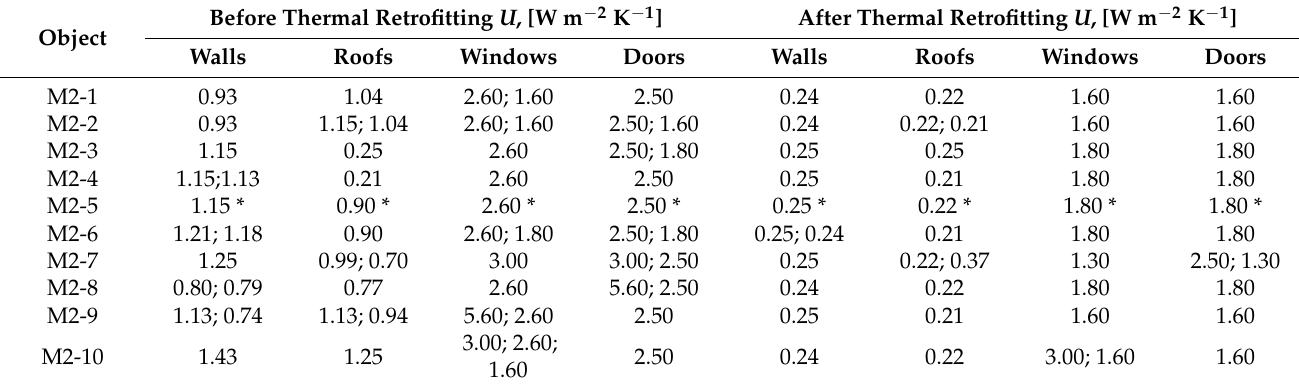
Table 4. Heat transfer coefficients U for external partitions in buildings from group